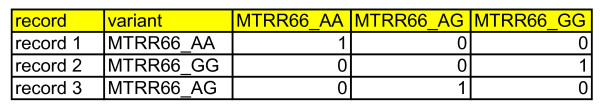
Method of coding the polymorphisms in the database. The code assigned to the polymorphisms transformed each polymorphism in three genotype classes: major homozygous, heterozygous and minor homozygous. For each class a binary coding was applied: 0 if variable absent; 1 if variable present. So for example considering the polymorphism MTRR 66A>G which can exist in three variants: AA (major homozygous), AG (heterozygous) and GG (minor homozygous). Supposing that three records are AA, GG and AG, the coding has been applied as shown in the figure.